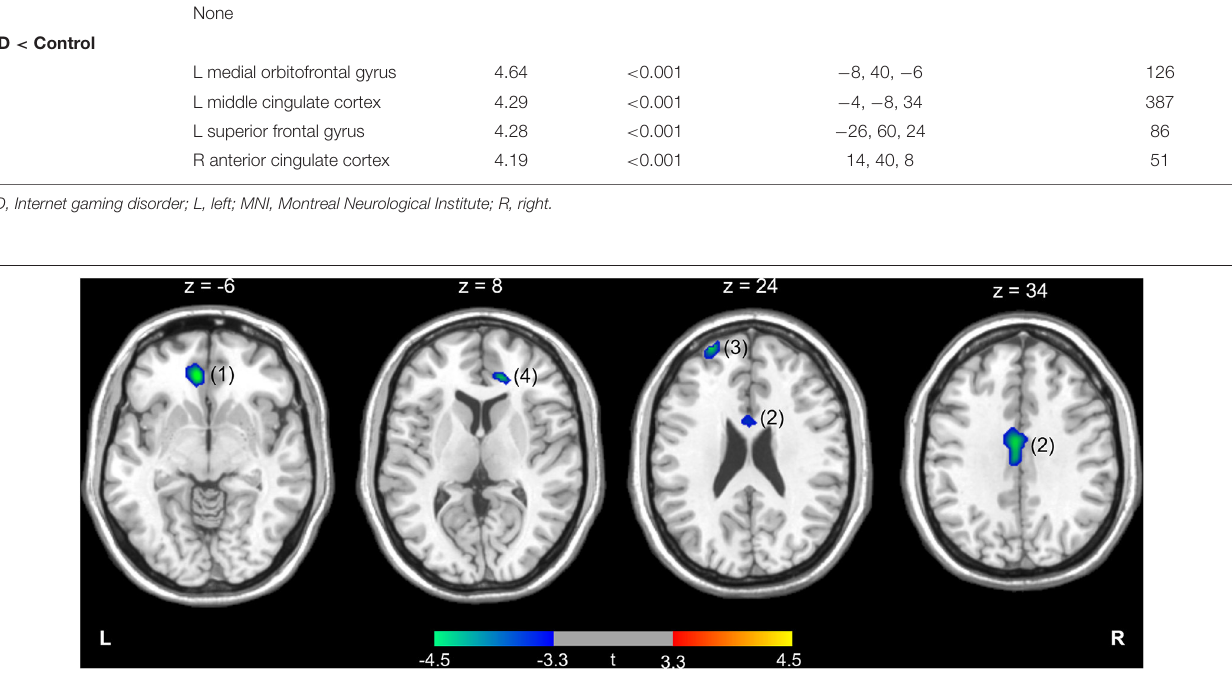
Frontiers in Psychiatry |